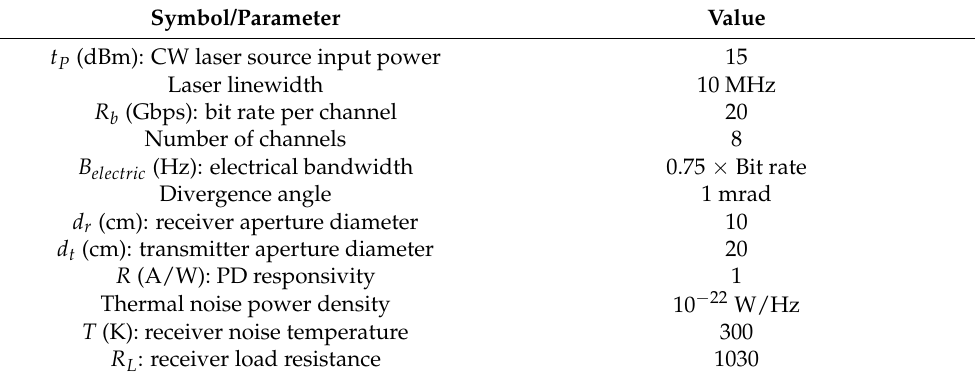
Table 2. Simulation parameters [27–31].